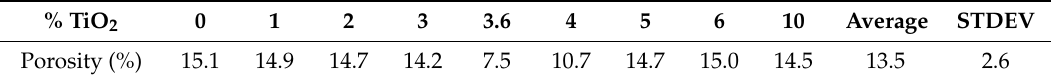
Table 1. Porosity of the cementitious composite